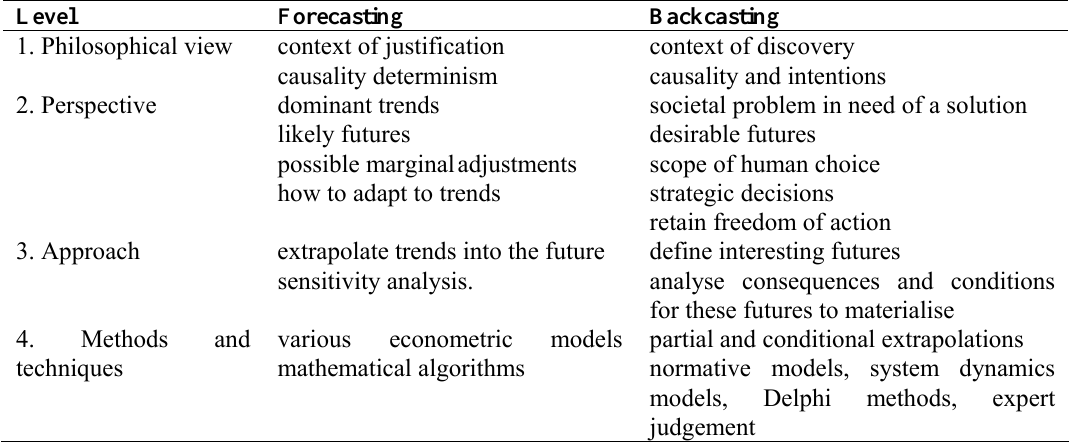
extrapolate trends into the future sensitivity analysis. Methods and various econometric models techniques mathematical algorithms Source: Adapted from Dreborg